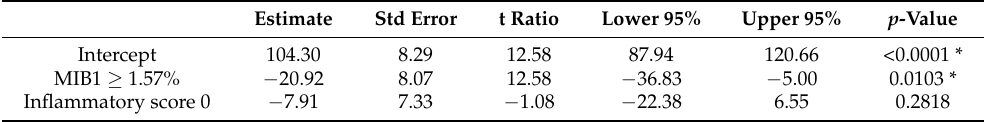
Table 2. Multivariate linear regression of percentual volumetric tumor